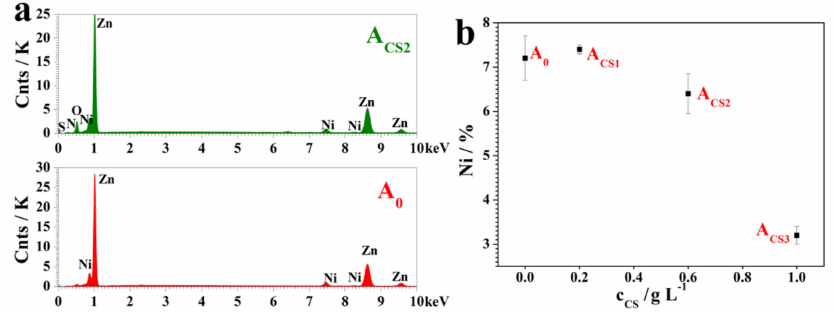
Figure 3. ( a ) The energy dispersive spectroscopy (EDS) results of A 0 and A CS2 , and ( b ) The Ni contents of the electrodeposited